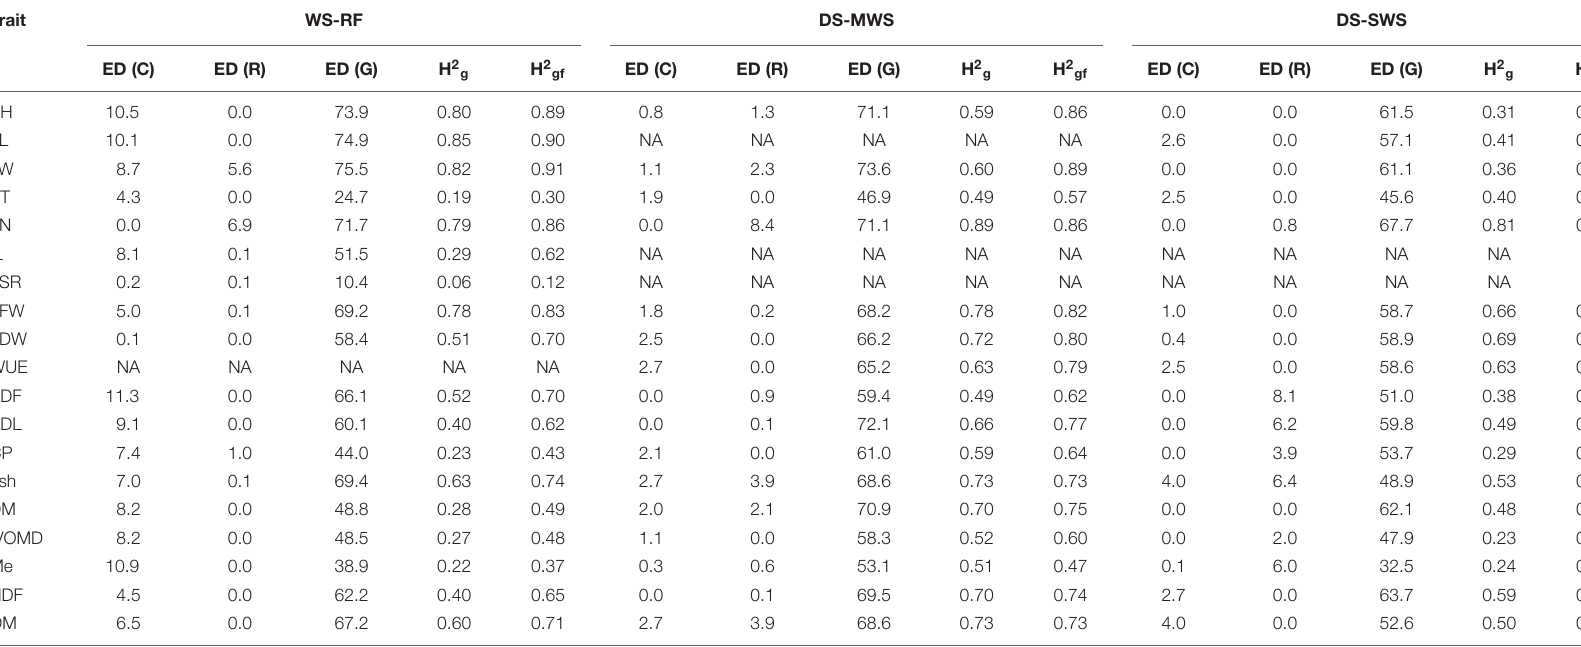
TABLE 1 | Estimated effective dimension (ED) associated with the spatial trend of the row (R), column (C), and genetic (G) random factors for each trait.